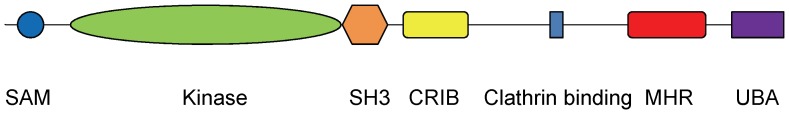
Ack1 domain architecture adapted from Prieto-Echague and Miller, 2011.SAM: Sterile Alpha Motif; CRIB: Cdc42/Rac-Interactive Binding region; MHR: MIG6 Homologous Region; UBA: Ubiquitin Association region.